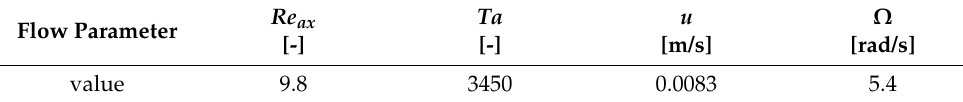
Table 2. Flow parameters for which wavy Taylor vortices are